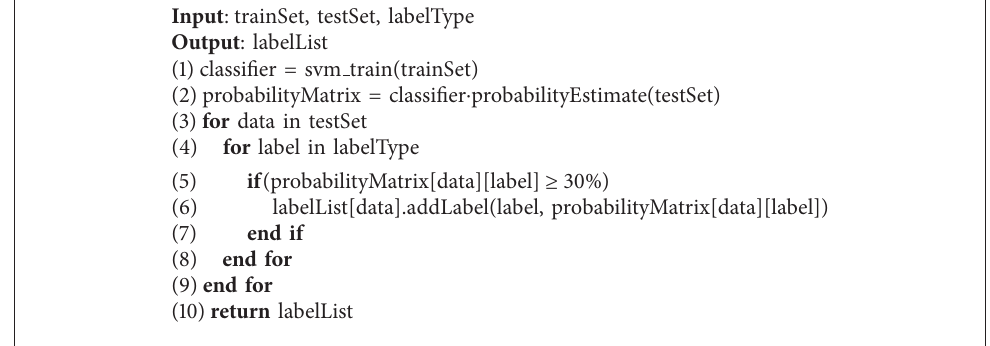
Algorithm 1: Label assigned.